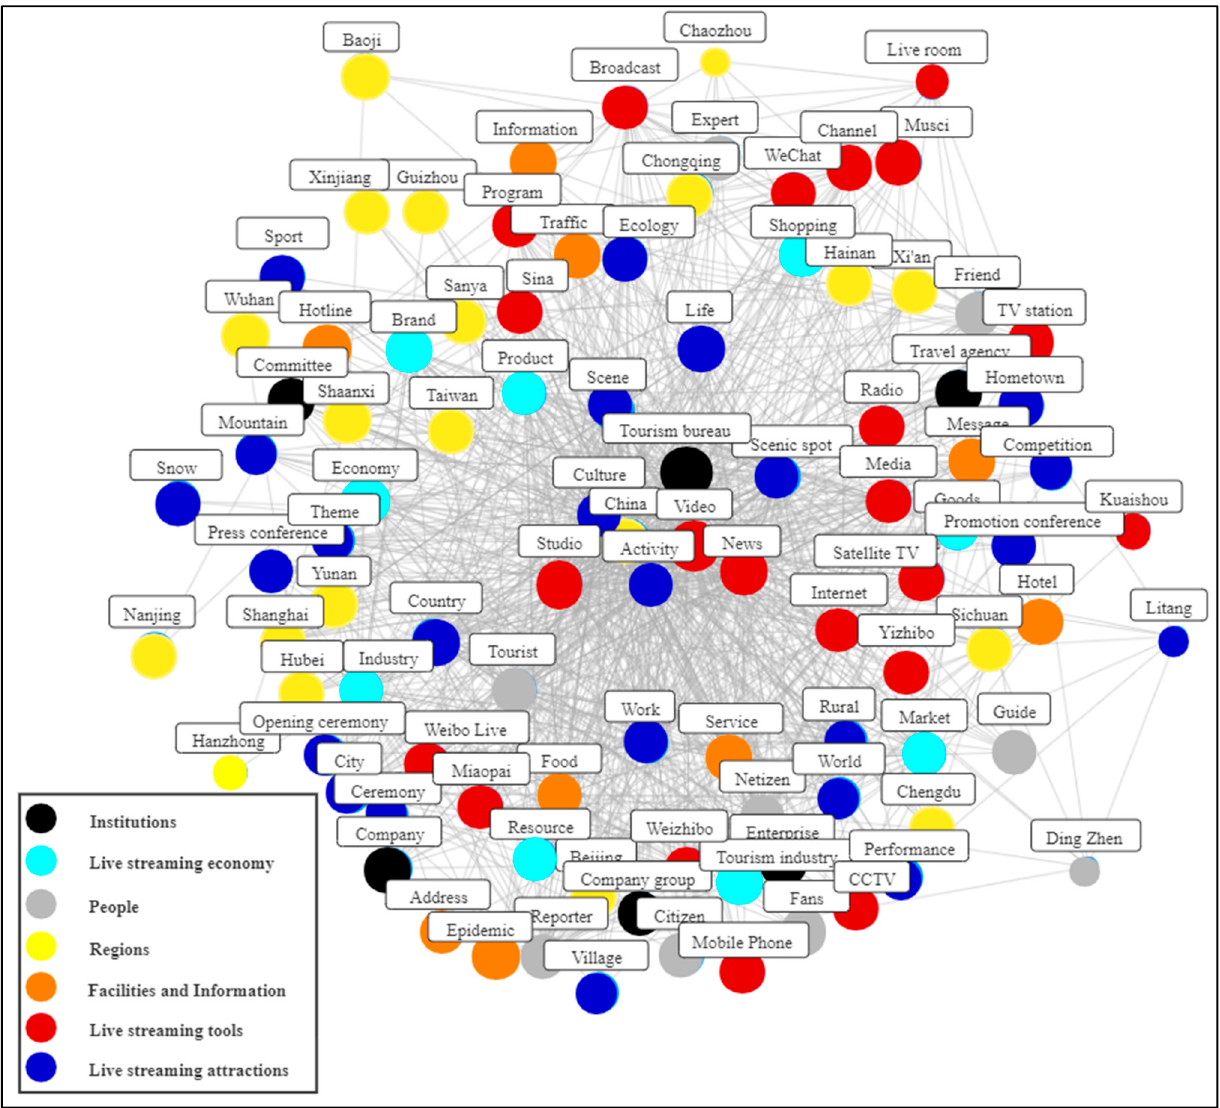
Figure 5. Semantic network results of tourism live streaming. Note: Different colors and dot sizes represent dimensions and degree centrality based on GooSeeker.